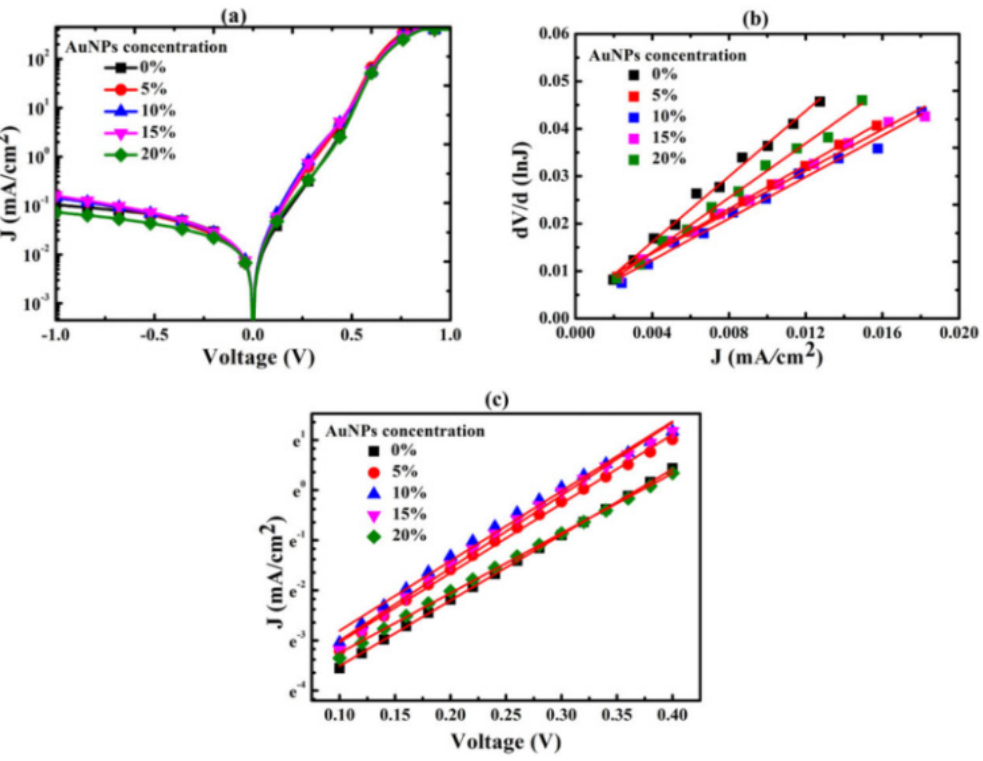
Figure 31. ( a ) Dark J - V characteristics of c-Si/PEDOT:PSS (AuNPs) heterojunction cells in the semilogarithmic scale; ( b ) series resistance (Rs) values extrapolated from d V /d(ln J ) versus J curves for various devices; ( c ) fitting of ln J versus V curves for estimating diode ideality factors. (Reproduced with permission from [155], Copyright John Wiley and Sons 2014).